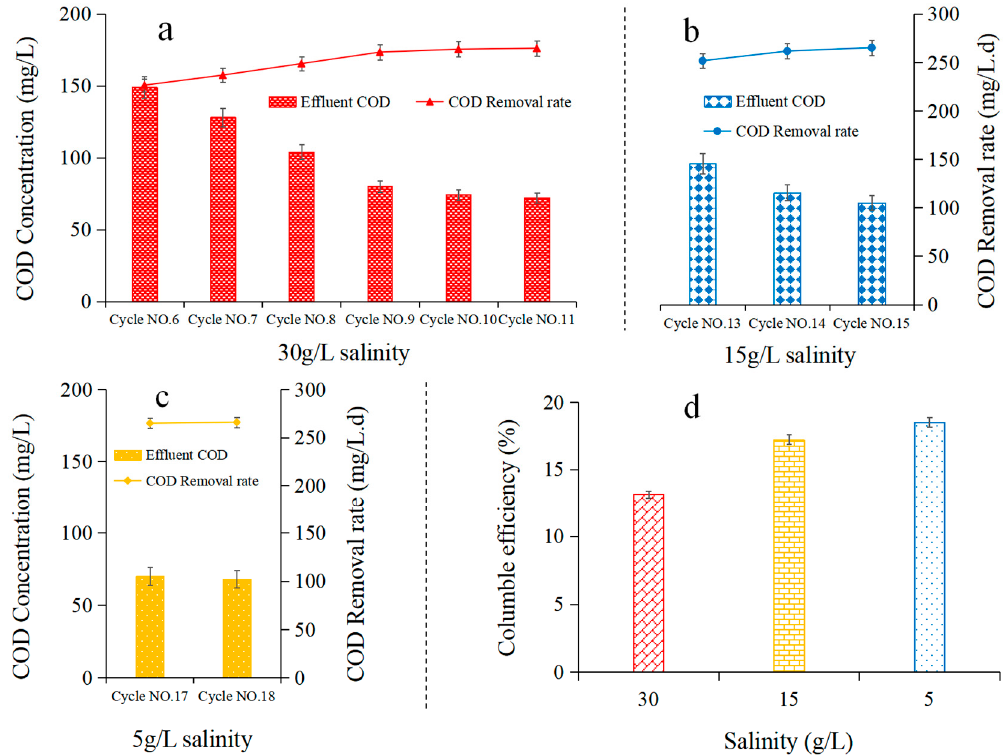
Figure 5. COD removal rate (( a ) 30 g/L, ( b ) 15 g/L, ( c ) 5 g/L salinity) and culombic efficiency ( d ) of the AMDC.